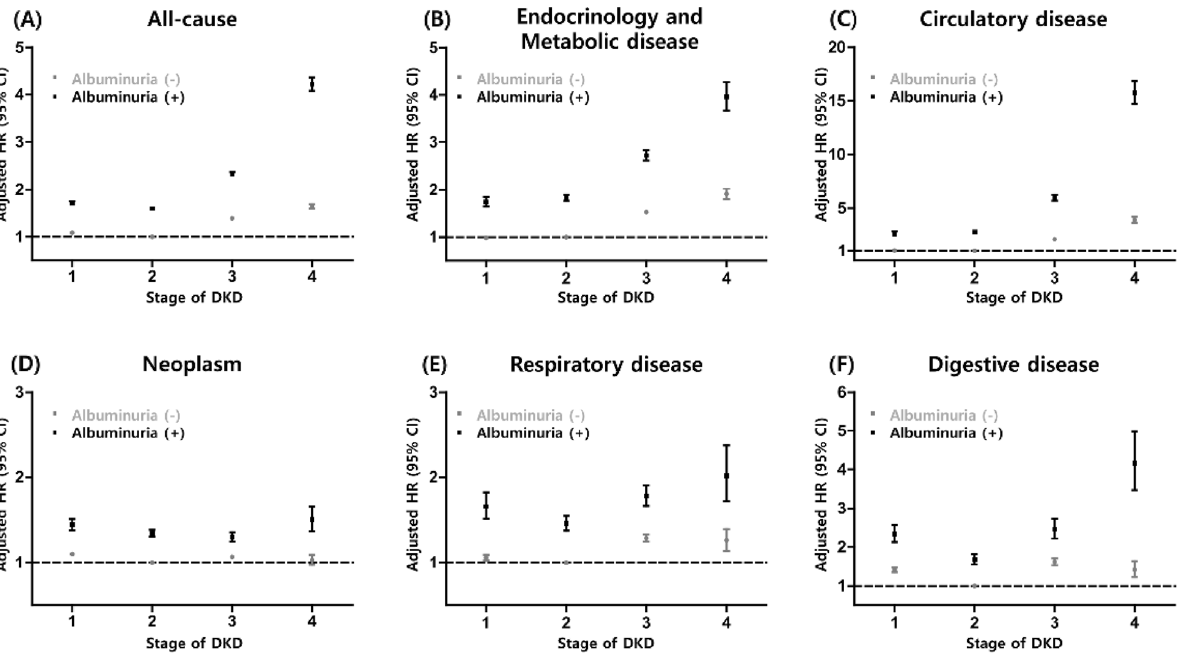
Figure 2. The adjusted risk of mortality from ( A) all causes, ( B ) endocrinology and metabolic diseases, ( C ) circulatory diseases, ( D ) neoplasms, ( E ) respiratory diseases, and ( F ) digestive diseases according to the stage of diabetic kidney disease. Adjusted variables were age, sex, body mass index, smoking history, alcohol consumption, physical activity and comorbidities such as hypertension, dyslipidemia, chronic obstructive pulmonary disease, cancer, and congestive heart failure. HR hazard ratio; CI confidence interval; DKD diabetic kidney